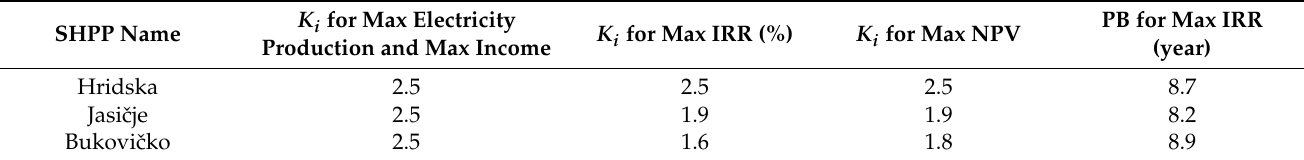
Table 5. Typical examples for Group I.